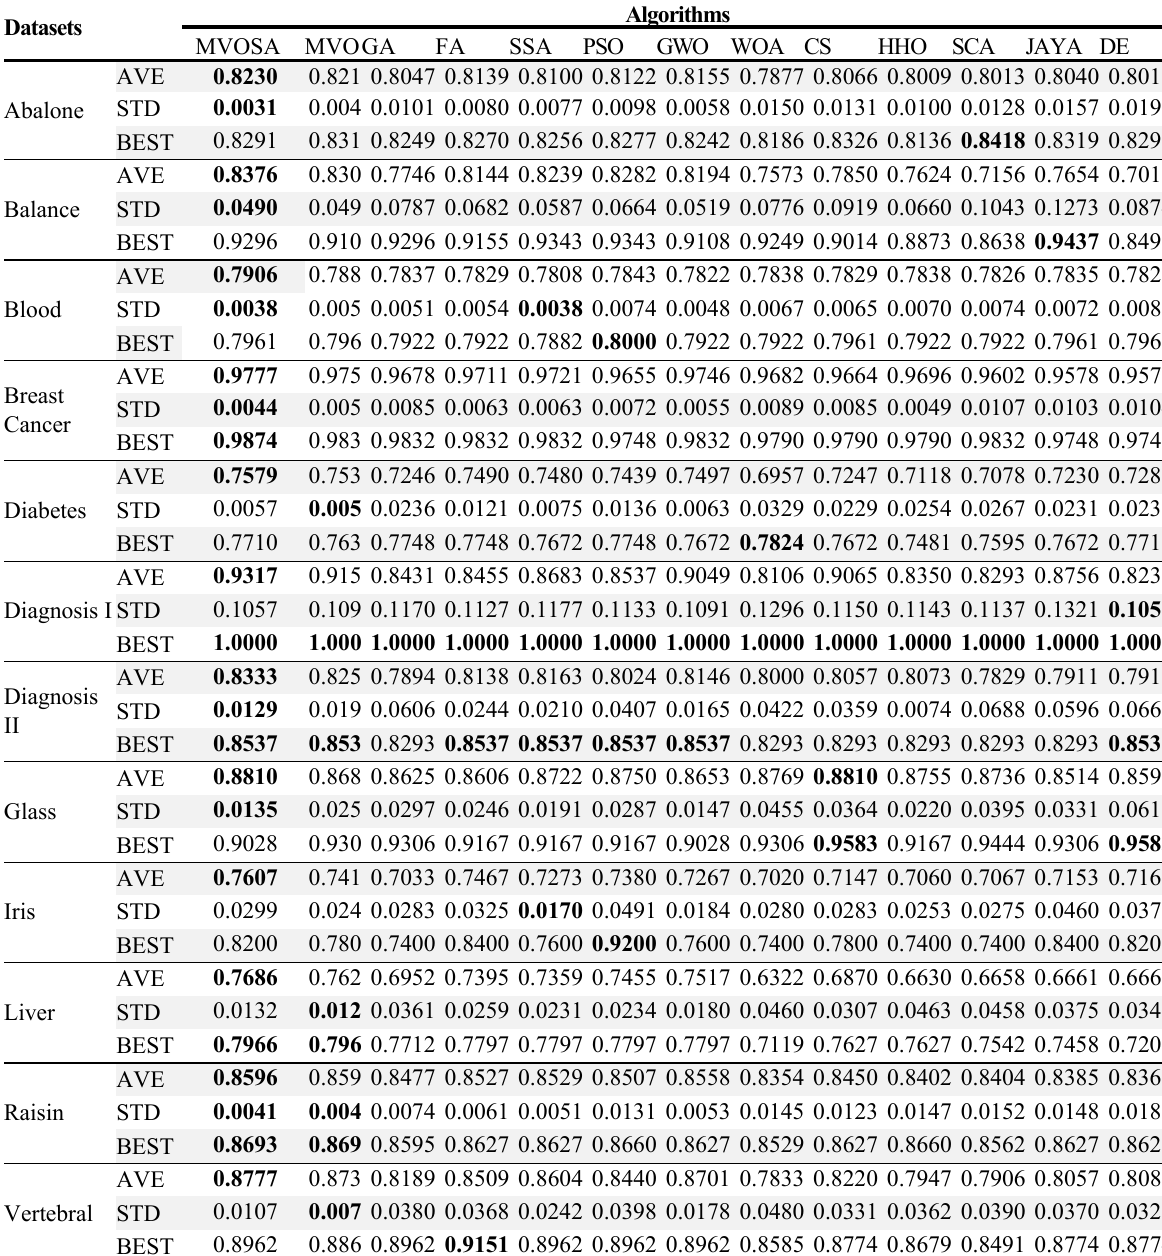
Table 4 Results of classification accuracy for all datasets and algorithms